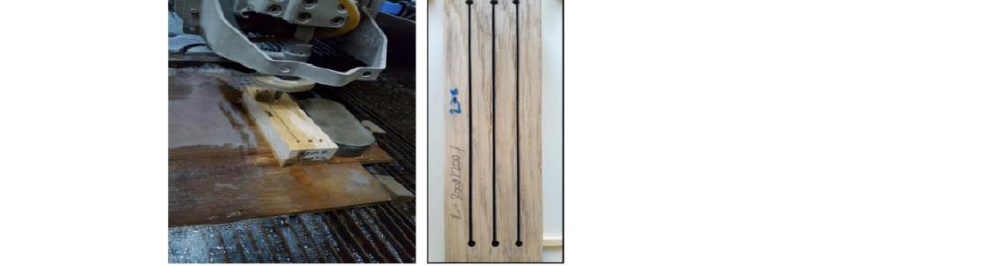
Figure 5. Cutting wood in an abrasive water jet (AWJ ) system ([71], reproduced from “Influence of processing parameters on the surface roughness of solid wood cut by abrasive water jet” with permission from NC State University, 2022).